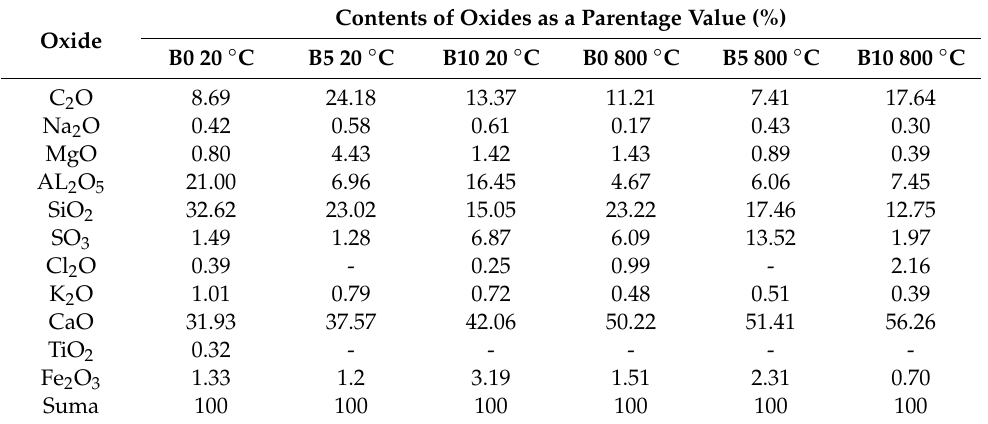
Table 7. Example of oxygen composition of the modified batch following the impact of thermal shock.